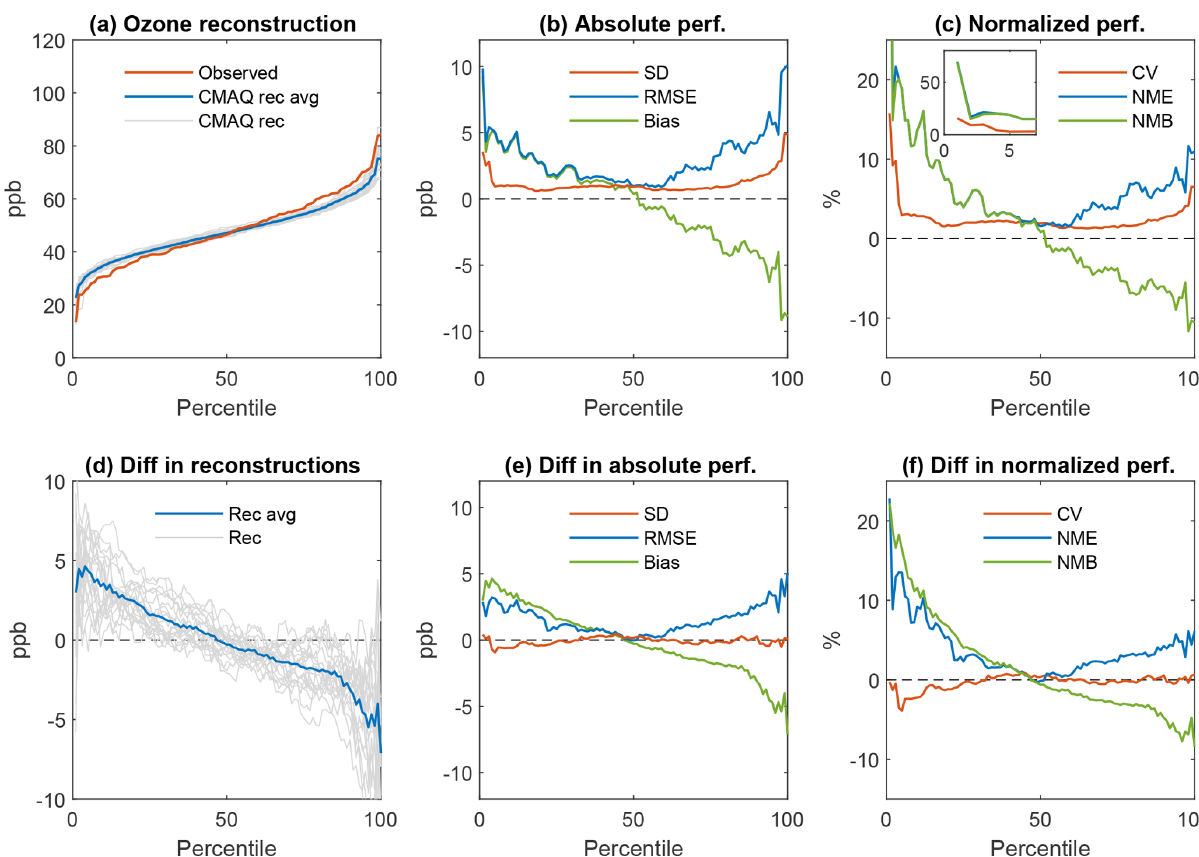
Figure 7. (a) Comparison between the observed CDF overlaid on 21 “pseudo-simulated” or reconstructed ozone CDFs with SY generated from modeled DM8HR ozone time series at a suburban site at Altoona, PA (AQS station identifier 420130801). (b) Display of various statistical performance (perf.) metrics derived by comparing the actual observed and pseudo-simulated ozone values in panel (a) . (c) Nor- malized statistical metrics. (d) Difference between the pseudo-simulated CDFs shown in panel (a) and the pseudo-observed CDFs as shown in panel (a) but calculated from 21 years (1990–2010) of observations only. The gray lines represent the differences for a specific SY year, while the blue line represents the differences between the means of the 21 reconstructions. (e) Difference between the absolute performance metrics for pseudo-simulations shown in panel (b) and those calculated for pseudo-observations as shown in panel (b) but calculated for 21 years (1990–2010) only. (f) As in panel (e) but for normalized performance metrics.